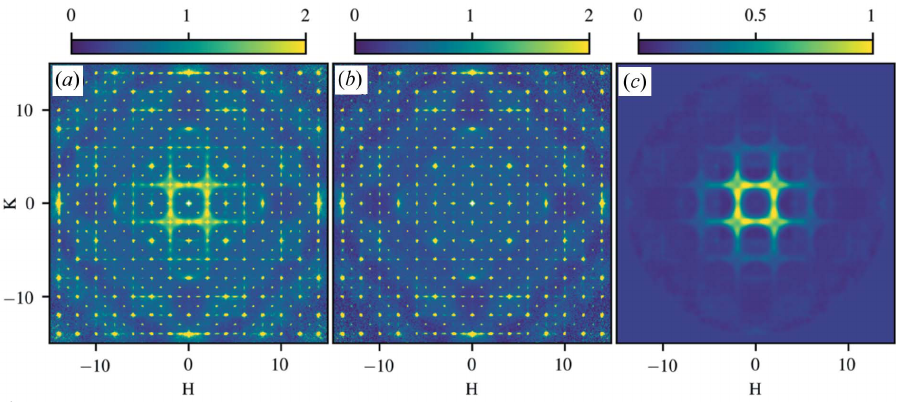
Figure 3 Reciprocal space neutron scattering for bixbyite. All figures are of the HK 0 plane. ( a ) Total elastic scattering at 7 K. ( b ) Total elastic scattering at 300 K. ( c ) Isolated magnetic diffuse